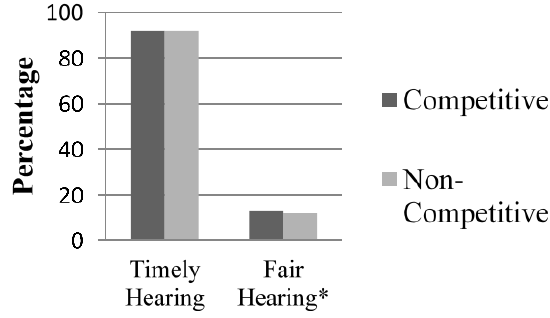
Figure 4. TennCare Appellate Hearings by Gubernatorial Competitiveness.